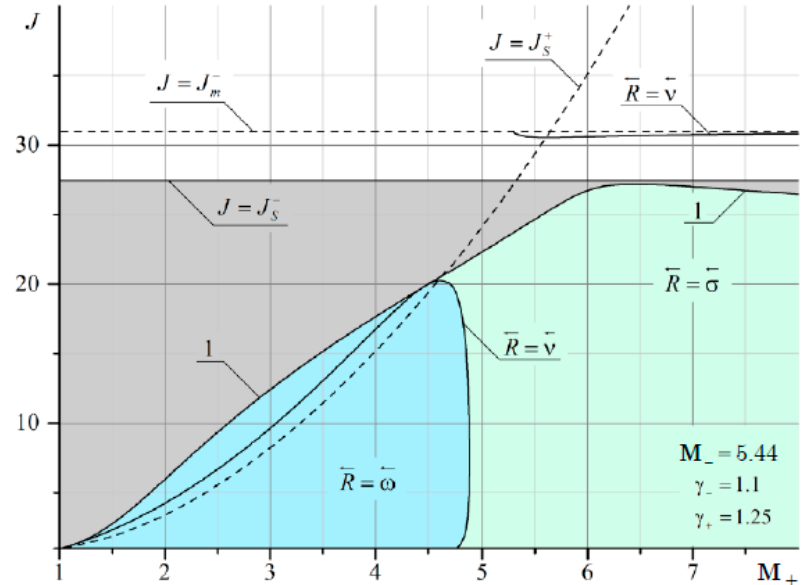
Figure A17. Domains of existence of reflected discontinuities for refraction from a propane/air/combustion product mixture at Mach number M – = 5.46 corresponding to Chapman–Judge detonation.